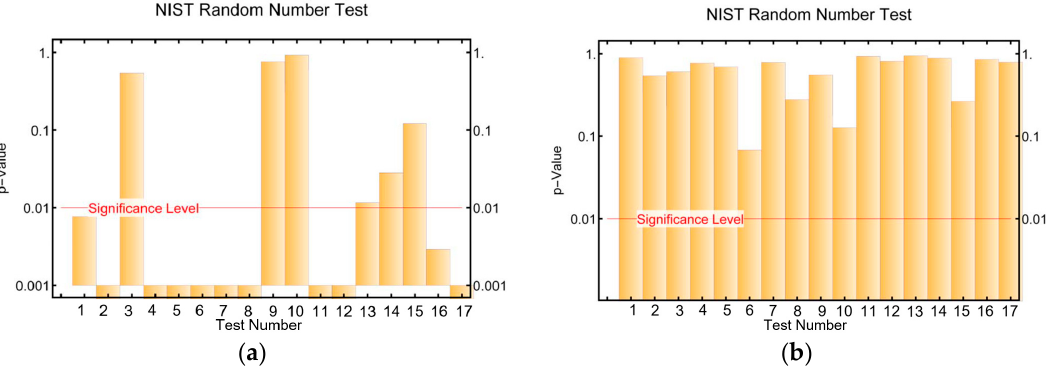
Figure 12. NIST test results for a sequence generated by ( a ) The STM algorithm; ( b ) The STM-LFSR algorithm. The tests numeration is the same as in Table 1.